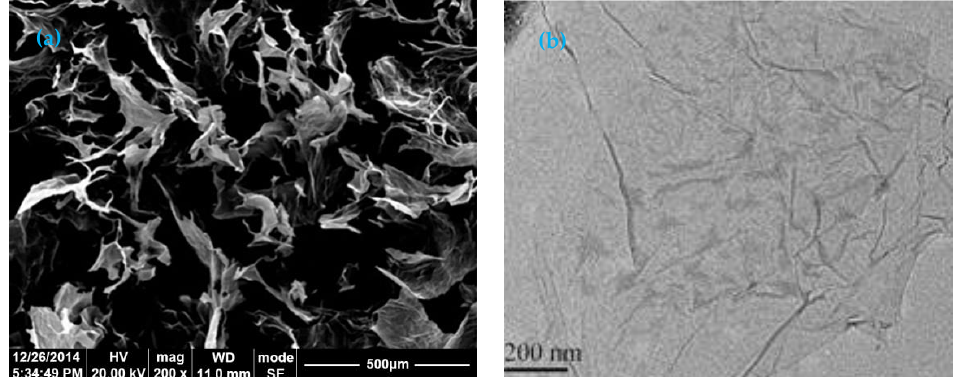
Figure 1. ( a ) Scanning electron microscope image of multilayer graphene oxide material; ( b ) Figure1. ( a )Scanningelectronmicroscopeimageofmultilayergrapheneoxidematerial; ( b )transmission transmission electron microscopy image of GO nanosheet. electron microscopy image of GO nanosheet.